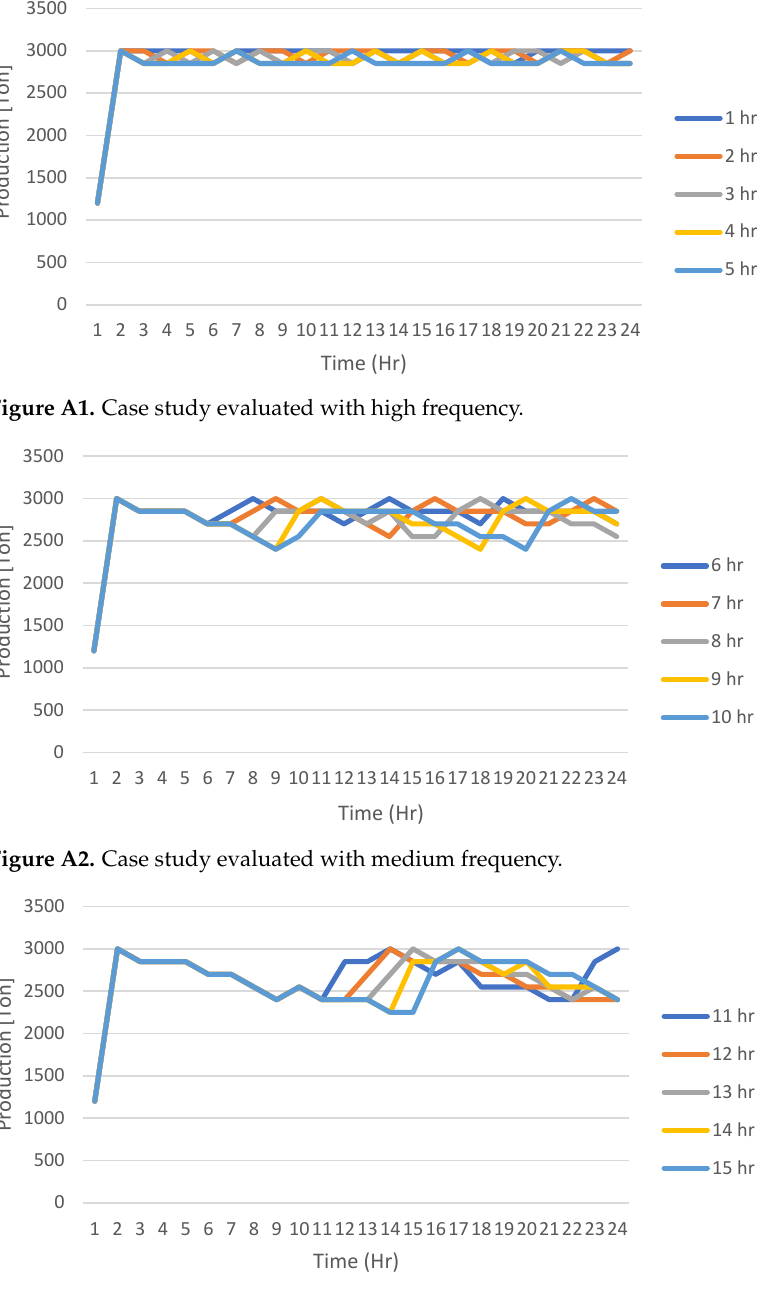
Figure A3. Case study evaluated with low frequency.